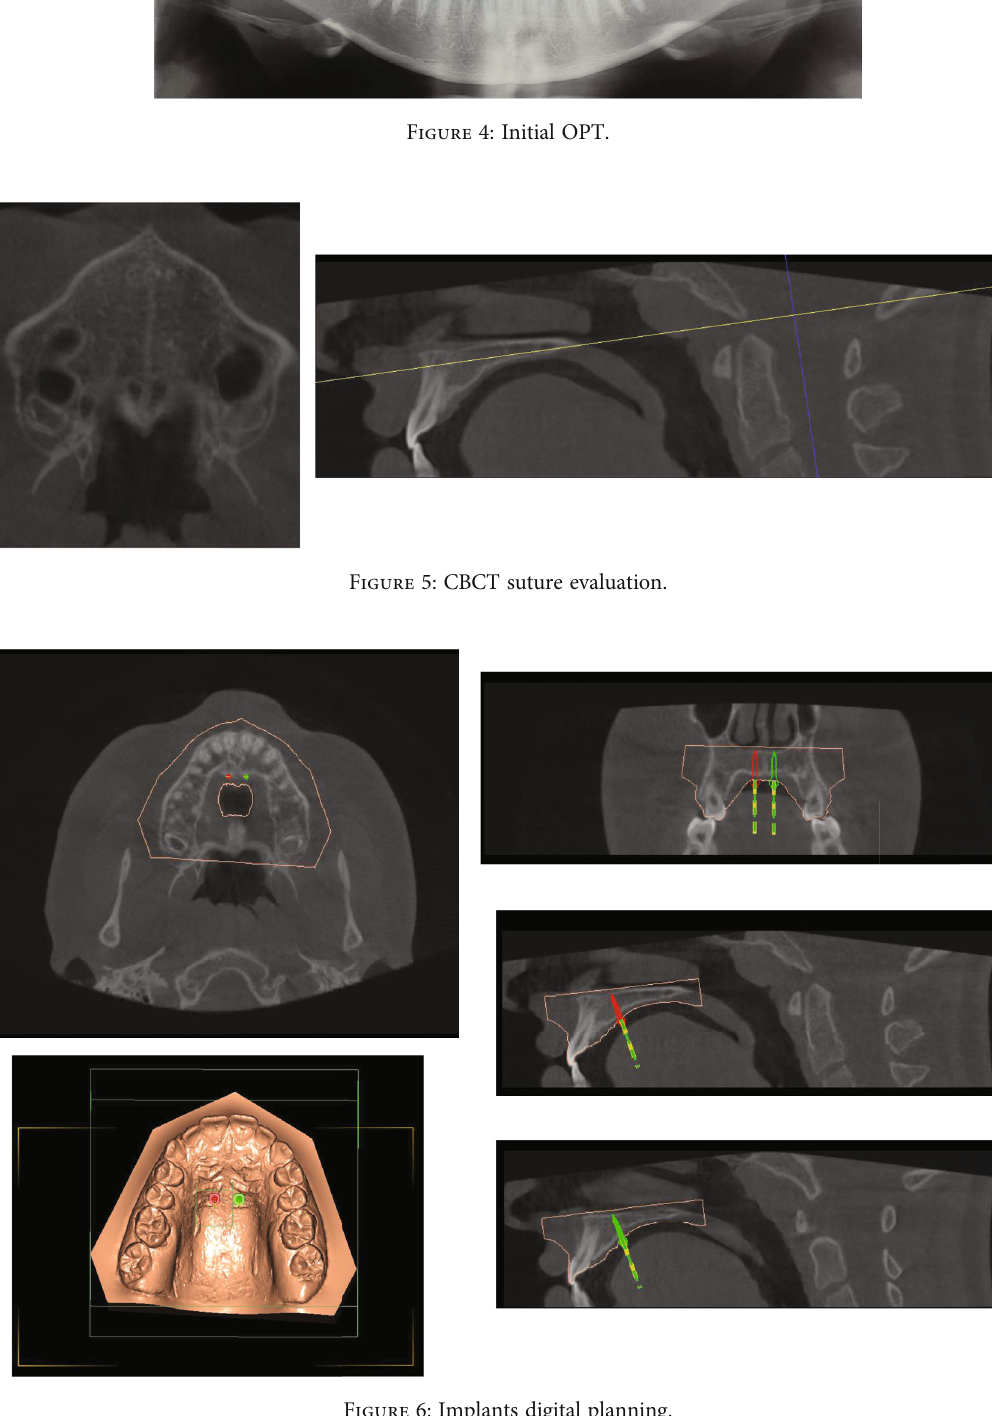
Figure 6: Implants digital